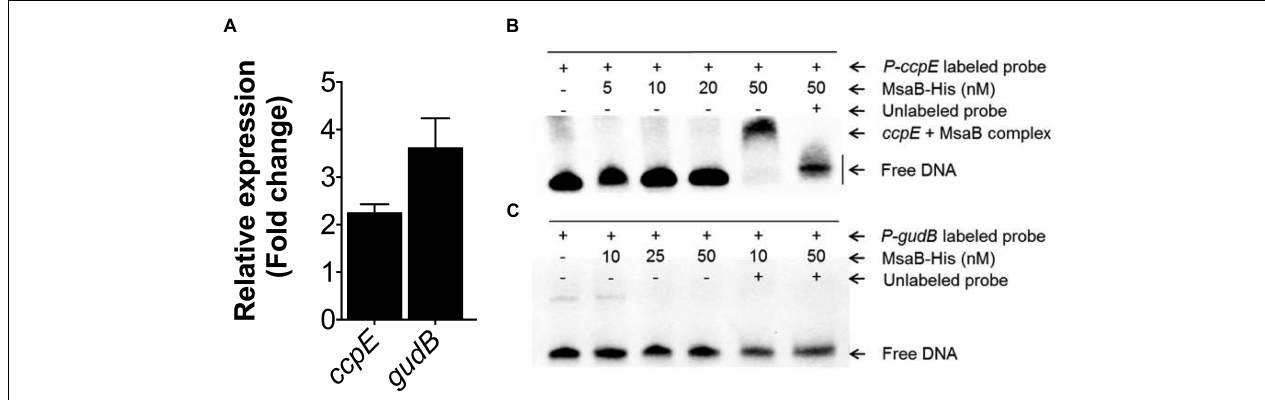
FIGURE 5 | Measurement of gene expression and electrophoretic mobility shift assay (EMSA). (A) Fold change expression of ccpE in late exponential growth phase and gudB in the chemically defined medium (CDM) for the (cid:77) msaABCR compared with the USA300 LAC strain, as measured by qRT-PCR. (B) MsaB binds to the ccpE promoter. Increasing concentrations of MsaB–His protein were incubated with a biotin-labeled, 50-bp, dsDNA probe incorporating the promoter region of ccpE . The band shift is shown in lane 5, while the shift was reversed in a competition assay with a 100-fold greater concentration of unlabeled probe in lane 6. (C) MsaB does not bind to the promoter of gudB as evidenced by the absence of band